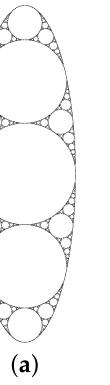
Figure 6. Apollonian packing for a / b = 5/4 ( a ) and for a / b = 2 ( b ). In both cases, r min = a /150.